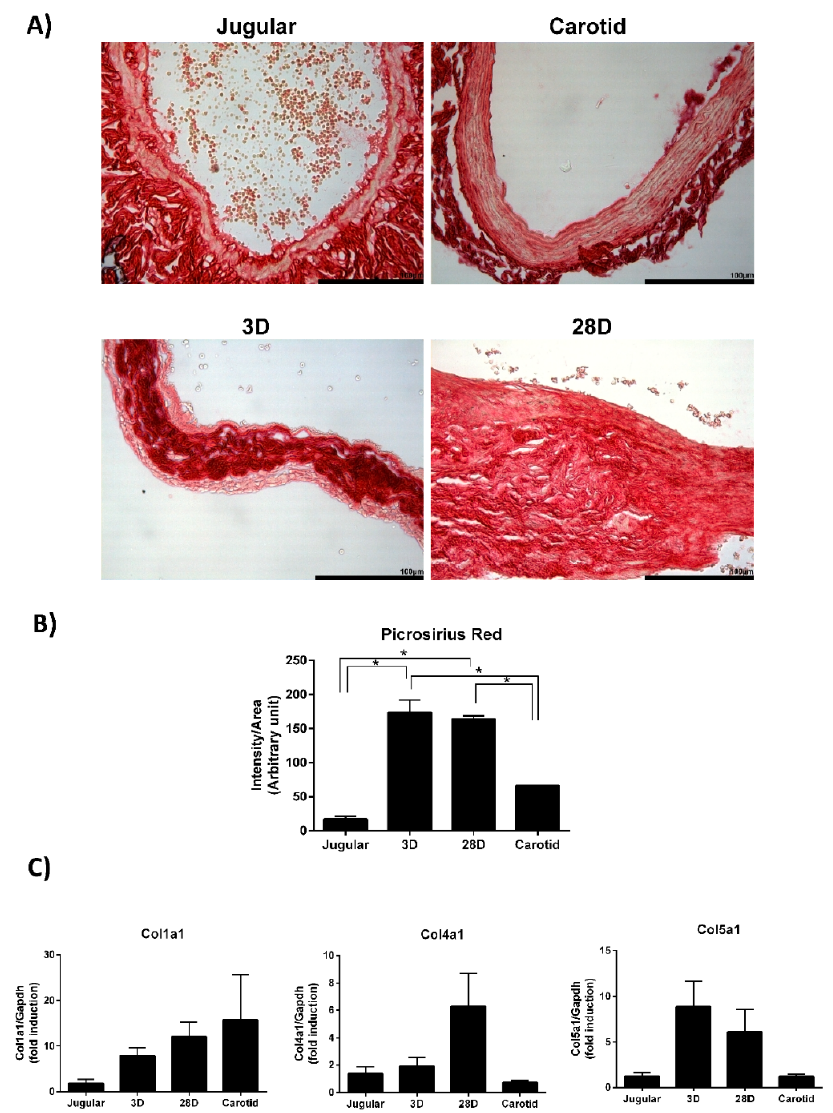
Figure 6. Collagen expression validation. ( A ) Representative images and ( B ) quantification of picrosirius red staining of arterialized jugular vein at 3 days ( n = 4) and 28 days ( n = 4). Normal jugular vein ( n = 3) and carotid artery ( n = 3) were used as controls. * indicates p < 0.05. ( C ) qPCR analysis of collagen genes to validate microarray data. Each bar represents the fold change of collagen expression compared with the level of expression in the jugular vein. Jugular ( n = 4), 3D ( n = 14), 28D ( n = 7), Carotid ( n = 5). * indicates p < 0.05.